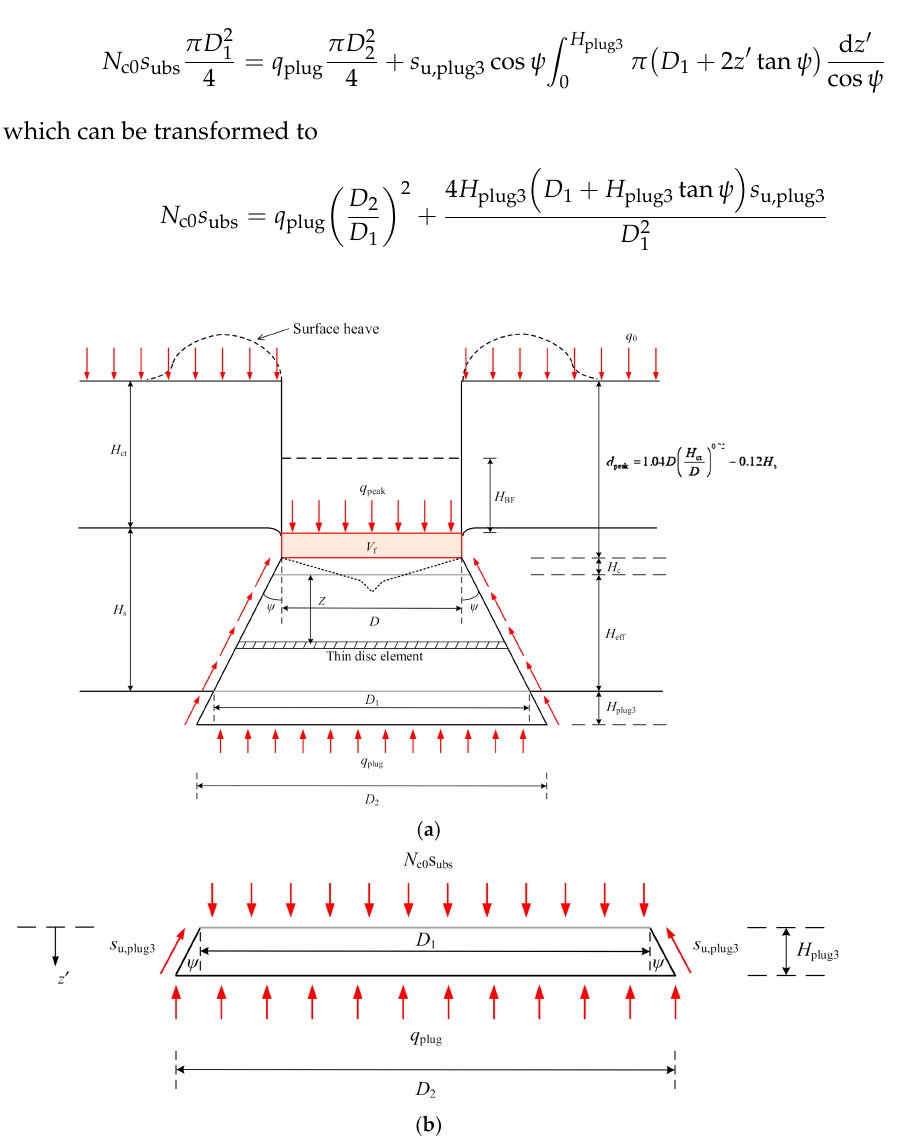
Figure 4. A modified predictive model for q peak . ( a ) Illustration of soil failure mechanism; ( b ) forces acting on the sand frustum in the bottom clay